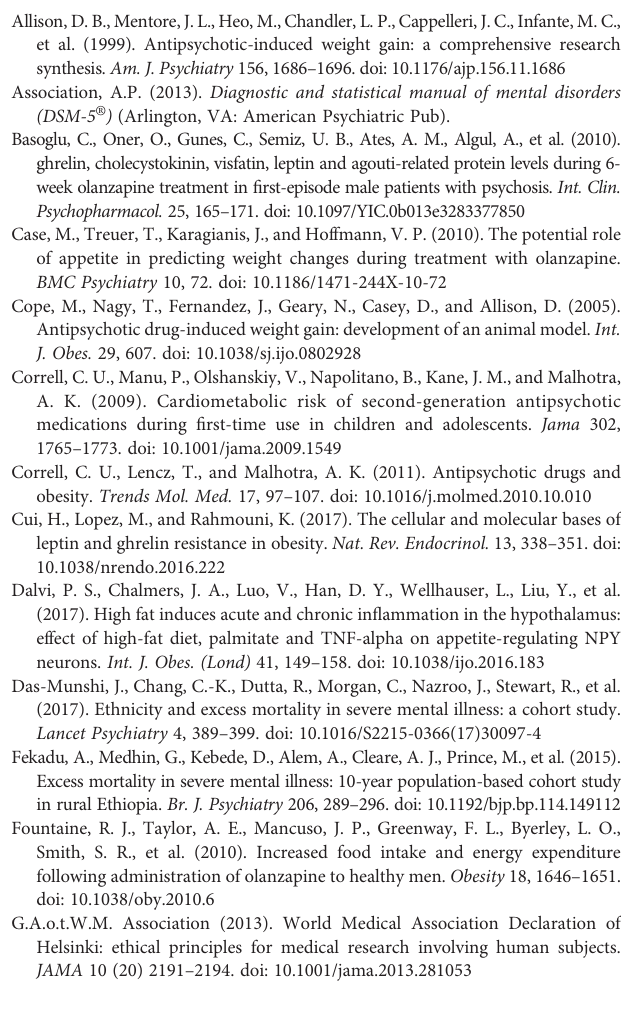
SUPPLEMENT TABLE 7-2 | Estimates of appetite effects on weight gain and metabolic-related outcome